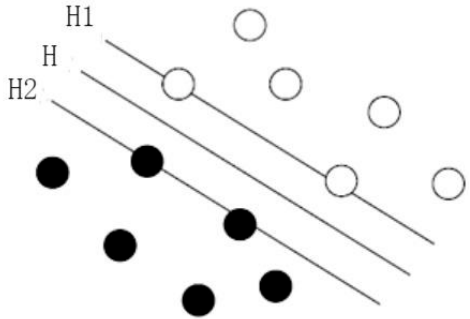
Figure 2. The optimal hyperplane diagram.